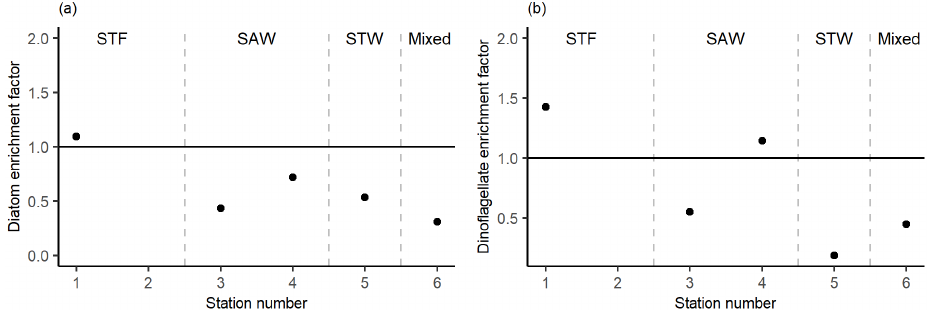
Figure 8. Phytoplankton carbon content enrichment factors for (a) diatoms and (b) dinoflagellates > 5µm. Water mass type is indicated by the label at the top of the figure and separated by the grey vertical dashed